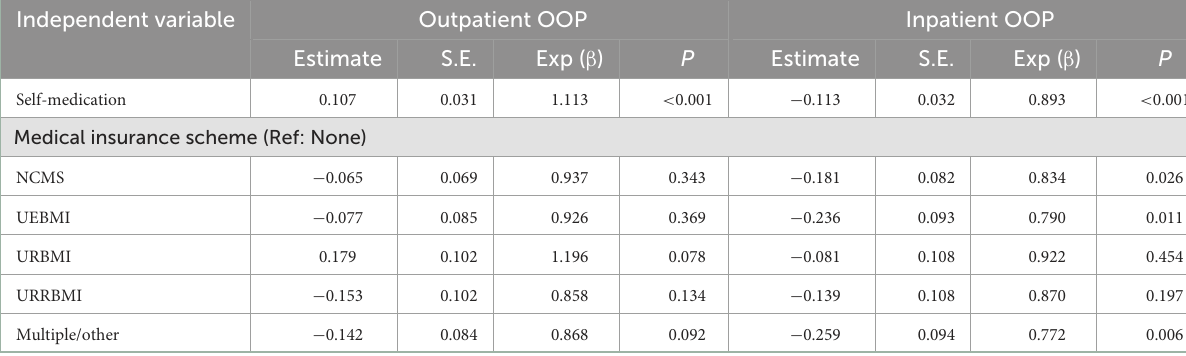
TABLE 5 Parameter estimates from regression equations on OOP costs. Independent